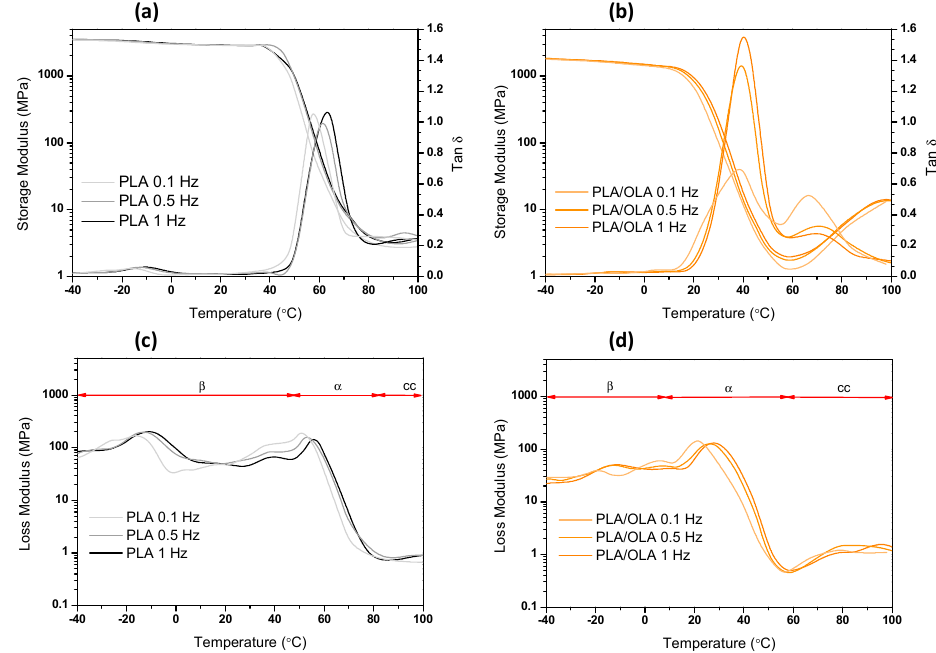
Figure 1. Temperature dependence of ( a ) poly (lactic acid) (PLA) and ( c ) PLA/lactic acid oligomer (OLA) storage modulus (E´) and loss tangent (tan δ ) and ( b ) PLA and ( d ) PLA/OLA loss modulus (E´´) at different frequencies (0.1, 1 and 3 Hz).